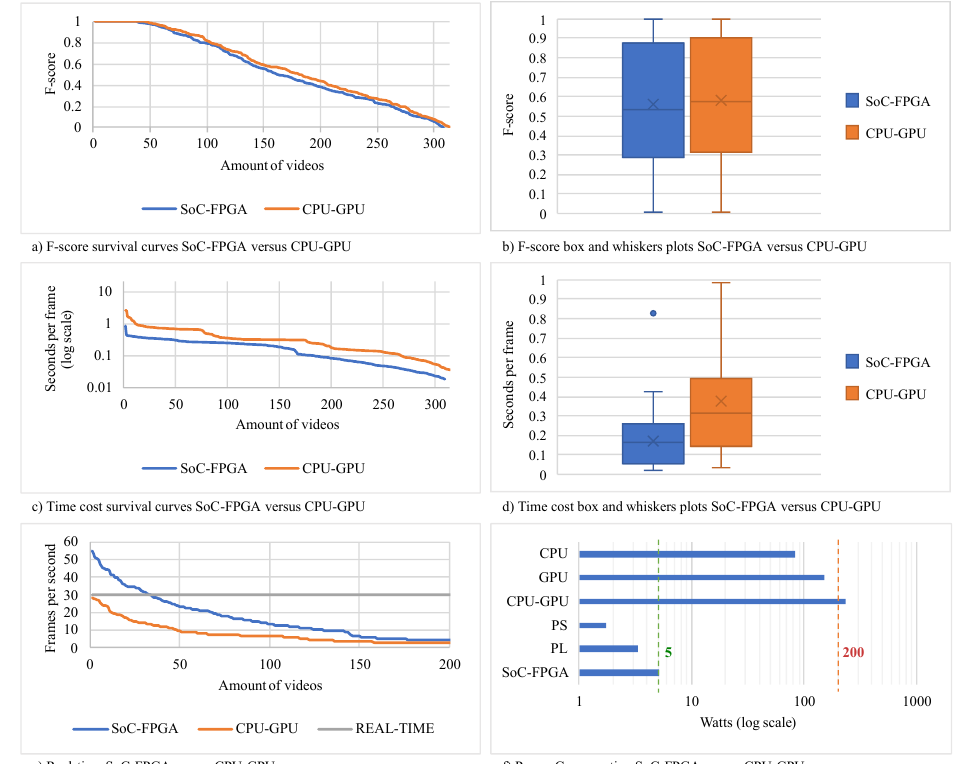
Figure 10. The compared video tracking systems use the same similarity measure (ZNCC) and the same meta-heuristic (HSA). The main difference between these proposals is the platform used to build the systems (SoC-FPGA or CPU-GPU). ( a ) SoC-FPGA versus CPU-GPU in terms of accuracy using survival curves. ( b ) SoC-FPGA versus CPU-GPU in terms of accuracy using box-and-whisker plots. ( c ) SoC-FPGA versus CPU-GPU in terms of time-costs using survival curves. ( d ) SoC-FPGA versus CPU-GPU in terms of time-costs using box-and-whisker plots. ( e ) SoC-FPGA versus CPU-GPU in terms of real-time video tracking. ( f ) SoC-FPGA versus CPU-GPU in terms of power